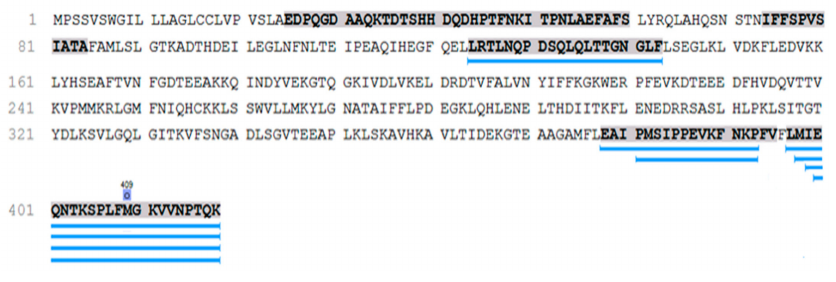
Figure 1. Amino acid sequence of the alpha-1-antitrypsin protein ( SERPINA1 ). Underlining shows seven urinary SERPINA1 peptides specific for preeclampsia according to pairwise Mann–Whitney U-test with Bonferroni correction ( p < 0.05). In bold, PE specific peptides selected by I. Buchimshi are shown [11].